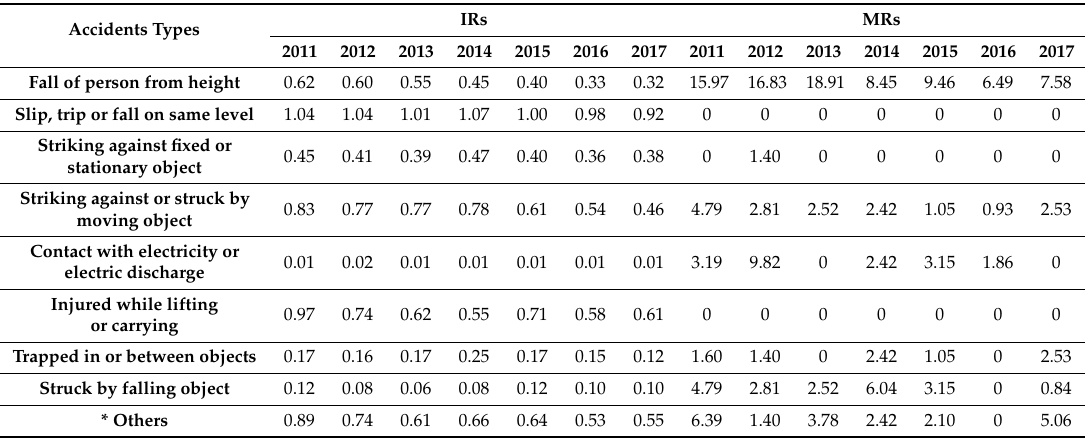
Table 3. The overview of incidence rates (IRs) and mortality rates (MRs) correspond to accident type from 2011 to